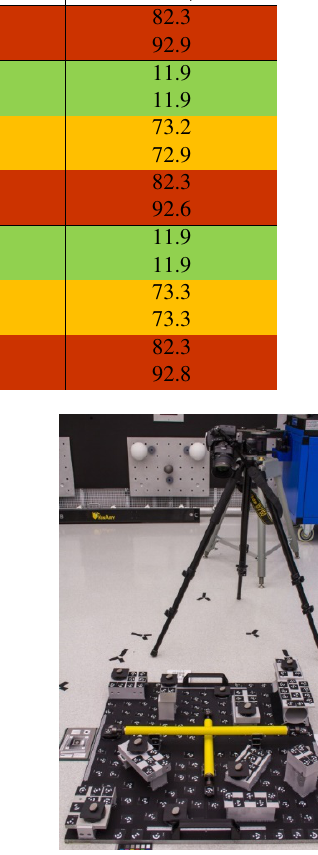
Figure 7: The 3D test object consisted of about 170 coded targets with a largest dimension of 900